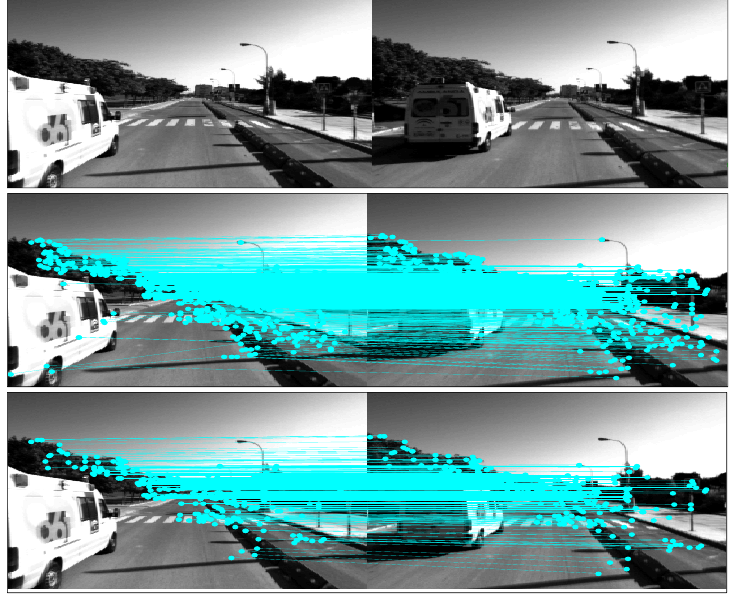
Figure 4. Feature matching and outlier removal between two image